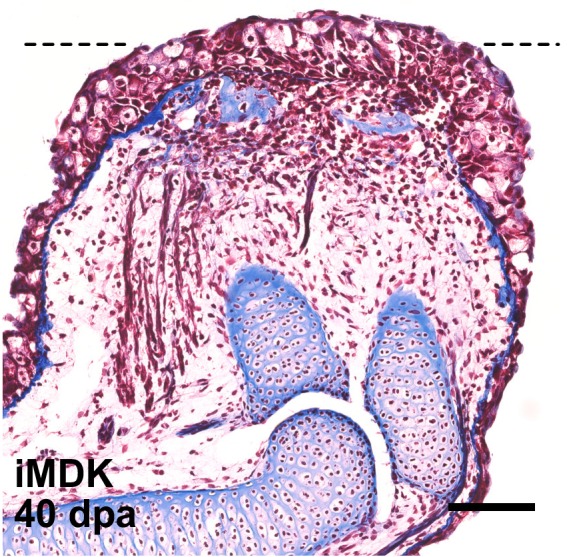
iMDK-treated limbs do not regenerate.Representative picro-mallory staining of a section from an iMDK-treated limb at 40 dpa. Re-formation of the blue collagen-thick dermal layer is commencing at the amputation plane (denoted with the black dotted line). Accumulation of fibroblastic blastemal cells can be seen at the amputation plane, although a blastema never forms. Scale bar, 200 µm.